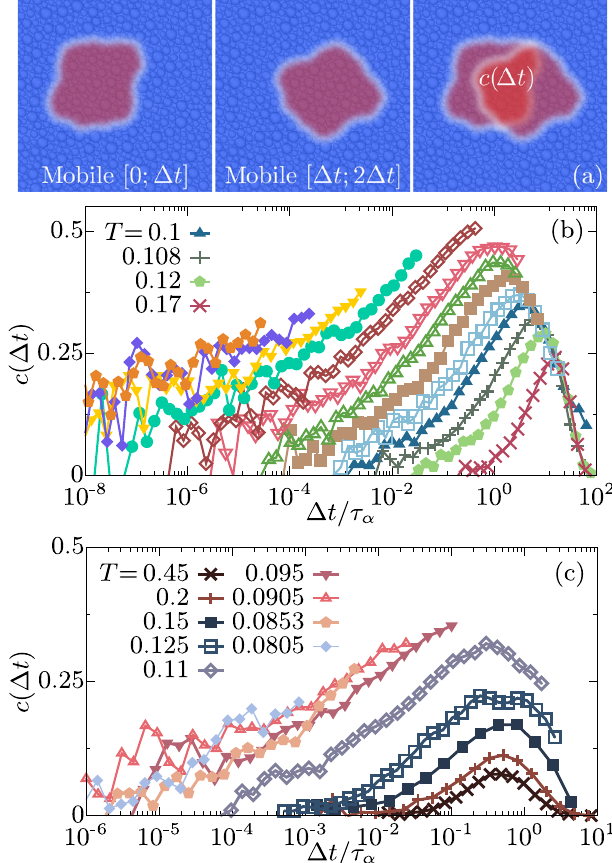
FIG. 17. The accumulation of relaxation events becomes more probable toward T . (a) The quantity c ð Δ t Þ in Eq. (15) quantifies g the probability for particles to be mobile within two consecutive intervals of duration Δ t . Data for c ð Δ t Þ in 3D [(b), legend provided in Fig. 1(a)] and 2D (c) liquids at various temperatures. The time axis is rescaled by τ α measured from F